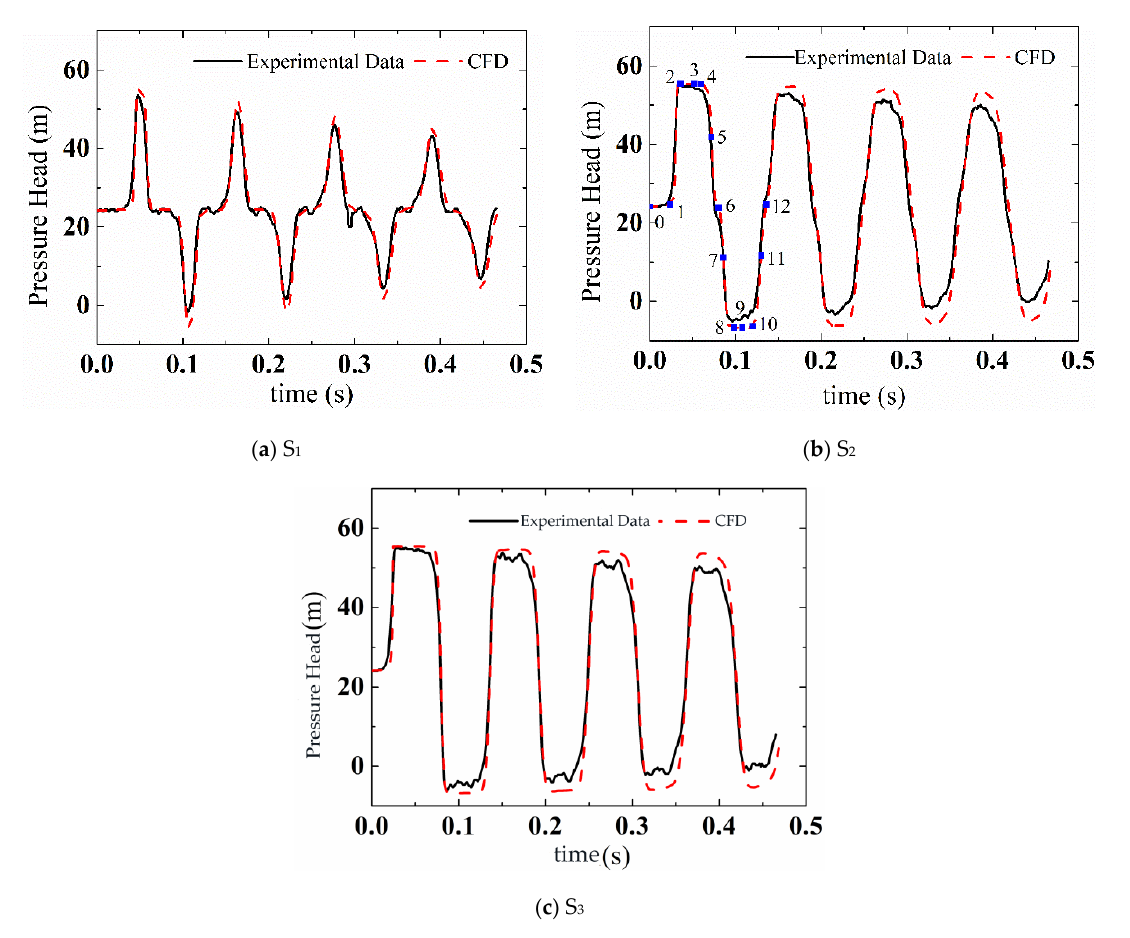
Figure 6. Comparison of experimental data and numerical simulation results of pressure head fluctuation at each monitoring point. ( a ) S 1 , ( b ) S 2 , ( c ) S 3 .